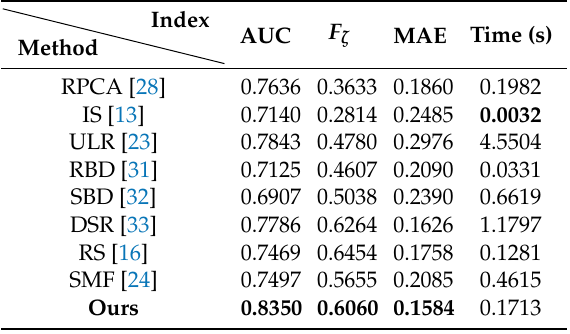
Table 2. Quantitative comparisons in terms of area under ROC (AUC), F ζ , mean square error (MAE), and Time.